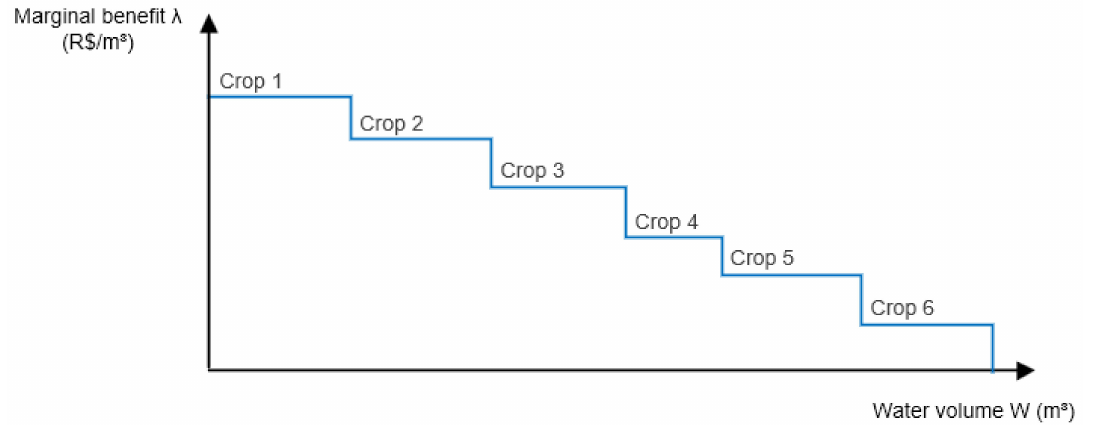
Figure 3. Marginal value in a given month in a given irrigation